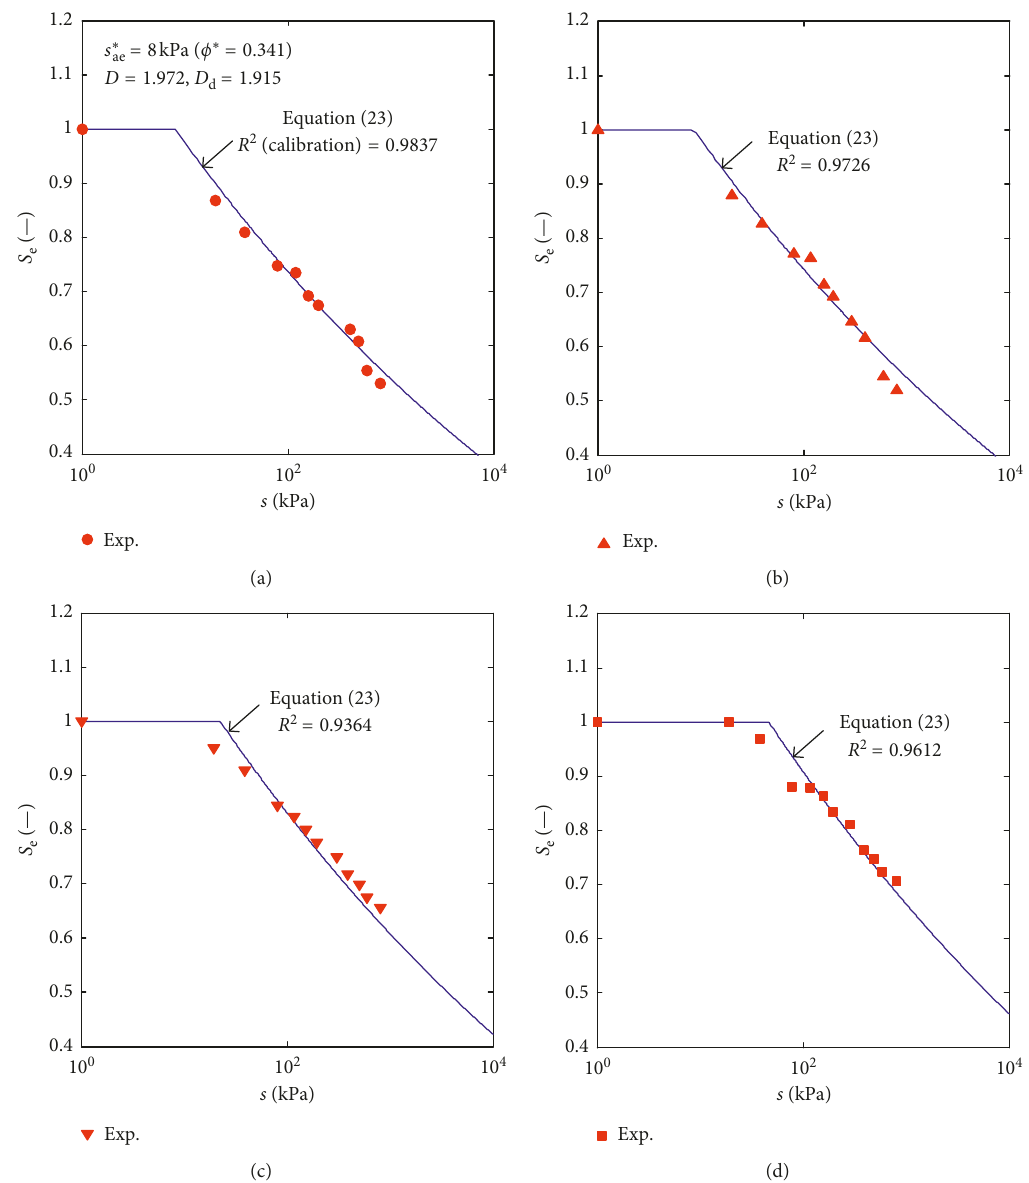
Figure 3: Measured and predicted SWRCs for specimens compacted at optimum water content (data after Vanapalli et al. [62]): (a) e � 0.517; (b) e � 0.514; (c) e � 0.474; (d) e �